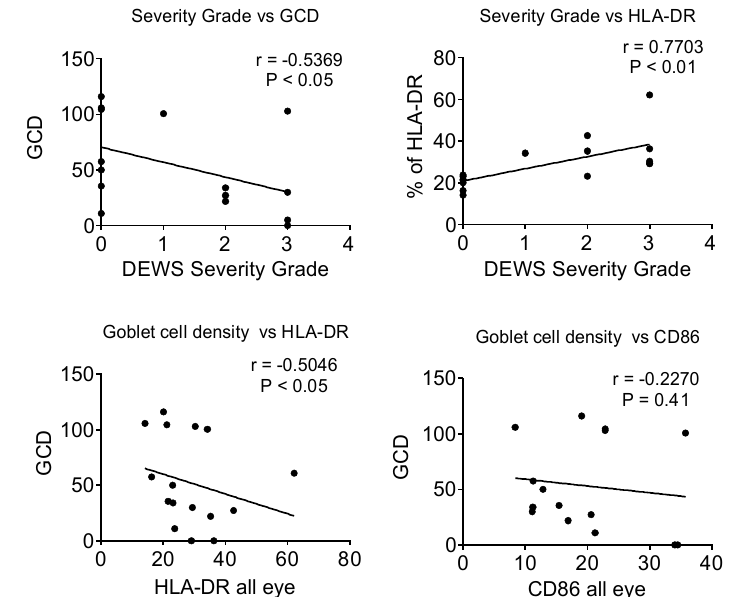
Figure 5. Correlations between clinical severity and goblet cell density (GCD) ( upper left ), clinical severity and percentage of HLA-DR + cells ( upper right ), percentage of HLA-DR + cells and GCD ( lower left ), and percentage of CD86 + cells and GCD ( lower right ). Correlations included the control and SS KCS subjects. Spearman r and p values are provided on graphs.